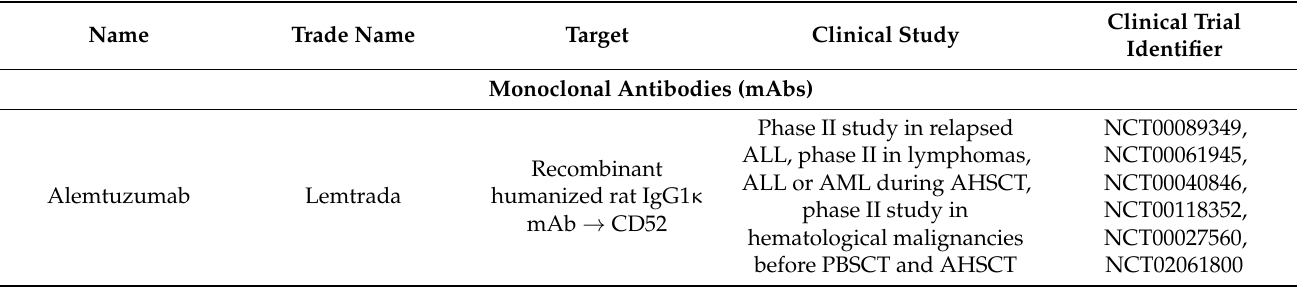
Table 1. Monoclonal antibodies, immune checkpoint inhibitors and CAR T-cell therapies in clinical trials for children with hematological